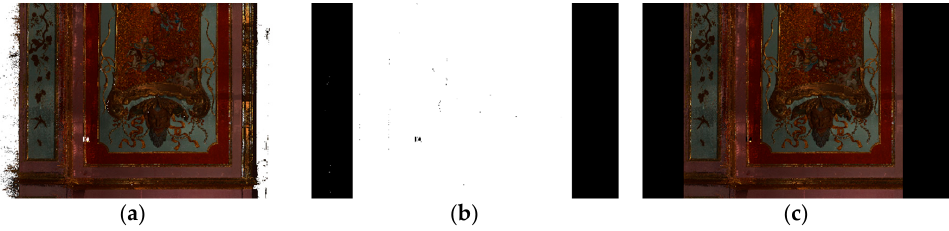
Figure 5. Illustration of the masks: ( a ) raw orthomap, ( b ) mask, and ( c ) result of filtration.